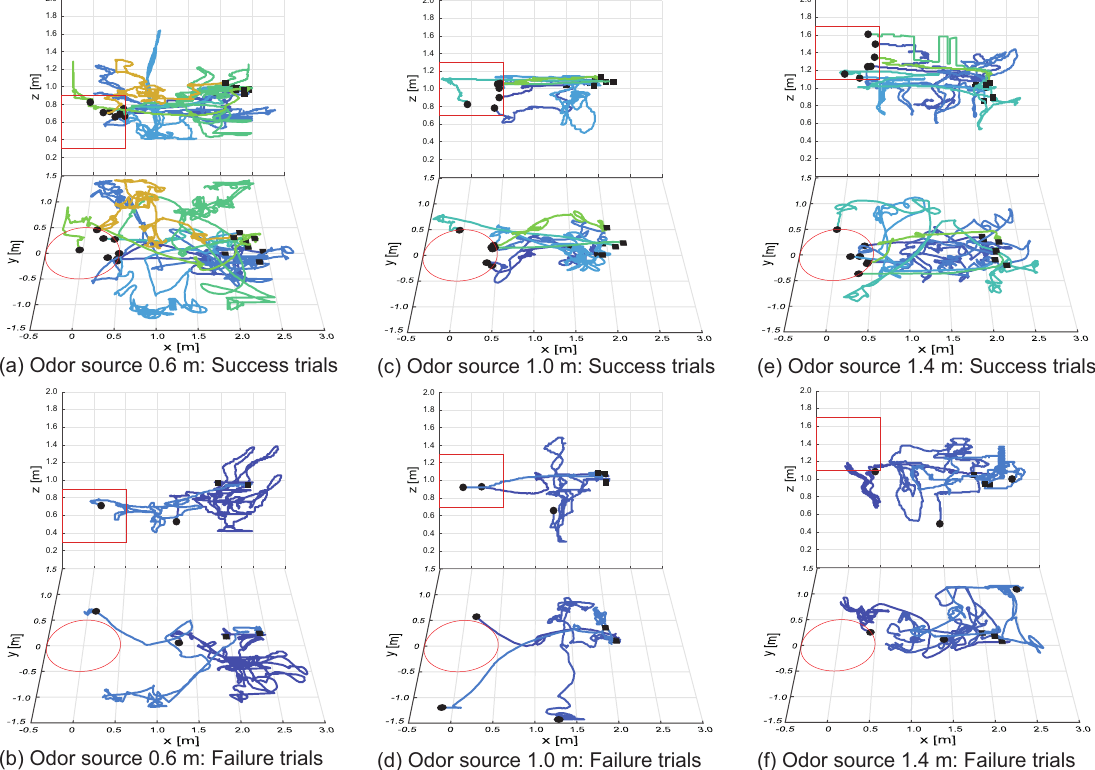
Figure 17. Migration pathway ratio map: subfigure ( a ) represents a success trial, and subfigure ( b ) represents a failure